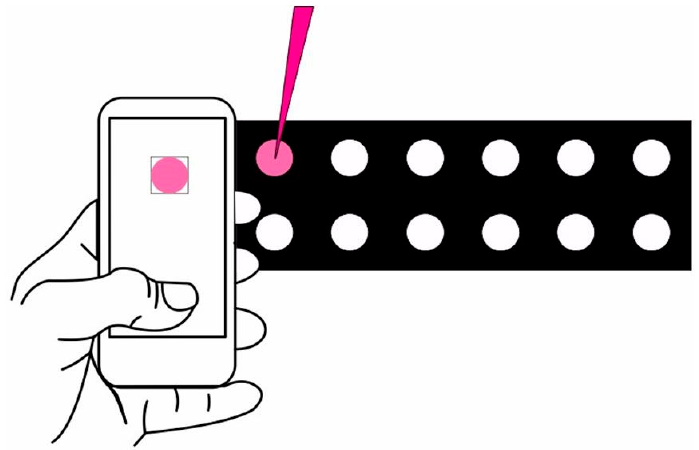
Figure 1. Scheme of paper devices for acid–base reactions and procedure for colorimetric reading by smartphone.